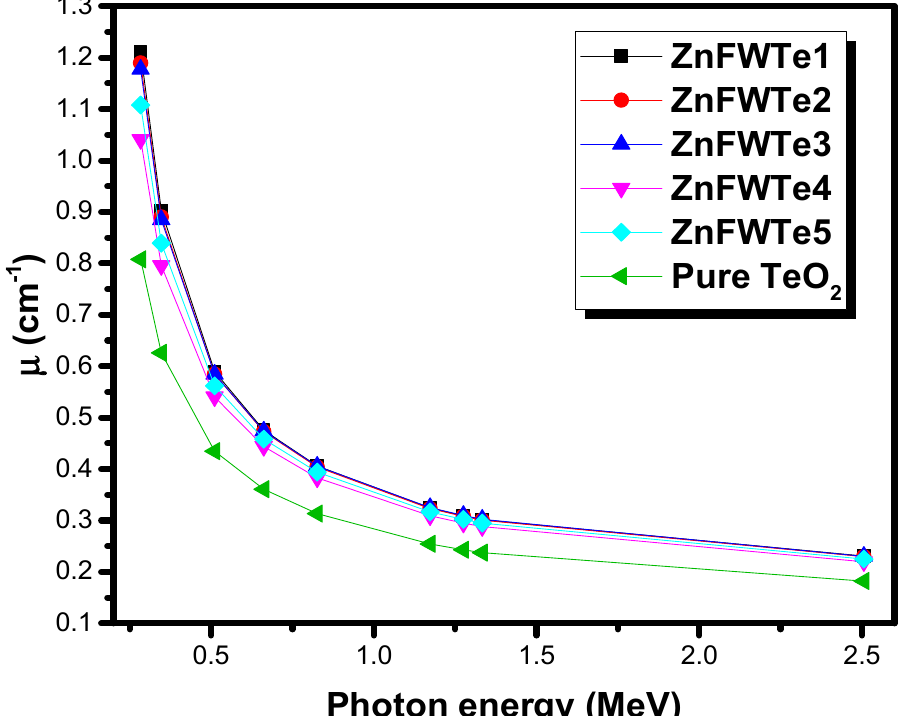
Figure 2. The linear attenuation coefficient for the selected oxyfluoride tellurite glasses.